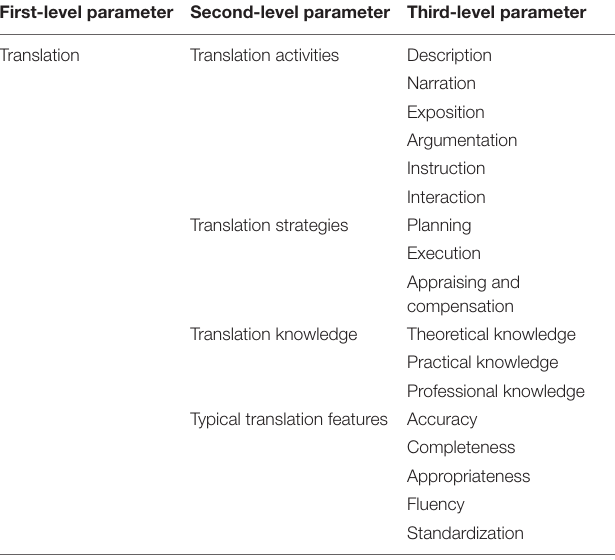
TABLE 1 | Descriptive parameter framework of CSE translation scales. First-level parameter Second-level parameter Third-level parameter